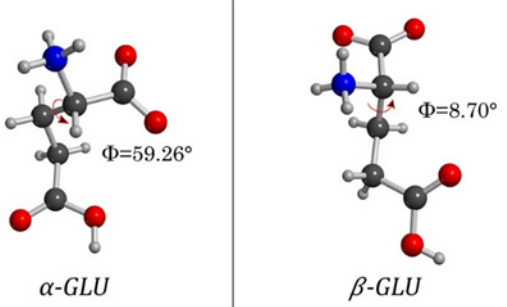
Figure 12. Molecular conformations of l-glutamic acid in α and β polymorphs, with the dihedral angles noted in the text indicated by curved arrows. Reprinted from [163].